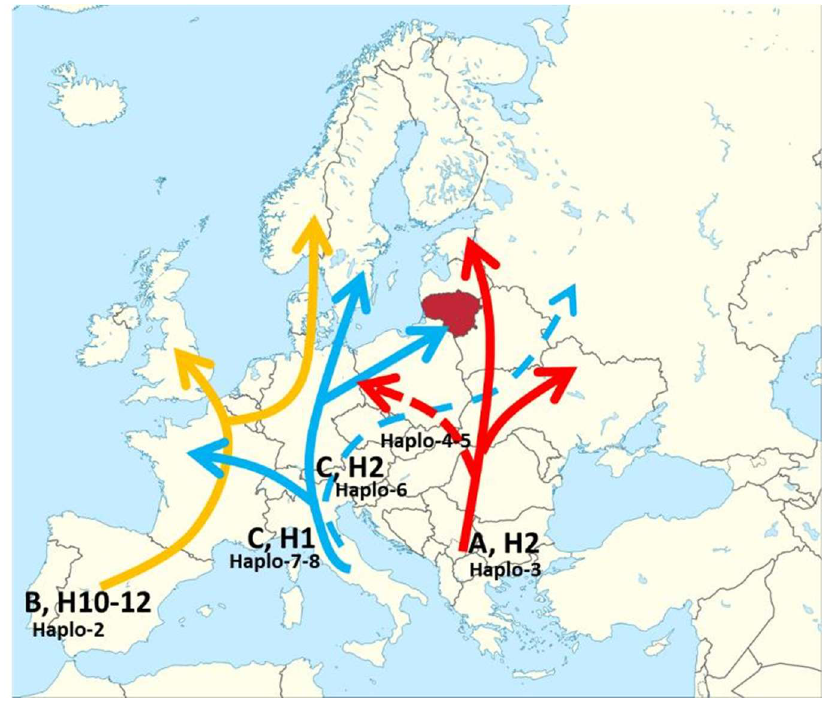
Figure 1. Simplified pathways of the main postglacial migration lineages of Q. robur based on [19] (noted by the capital letters A, B, C) and haplotypes as in [14] (noted by capital H ) and our study (noted by Haplo). Haplo-4–5 indicates the “German” branch of the Balkan lineage A. The location of Lithuania on the map is highlighted.